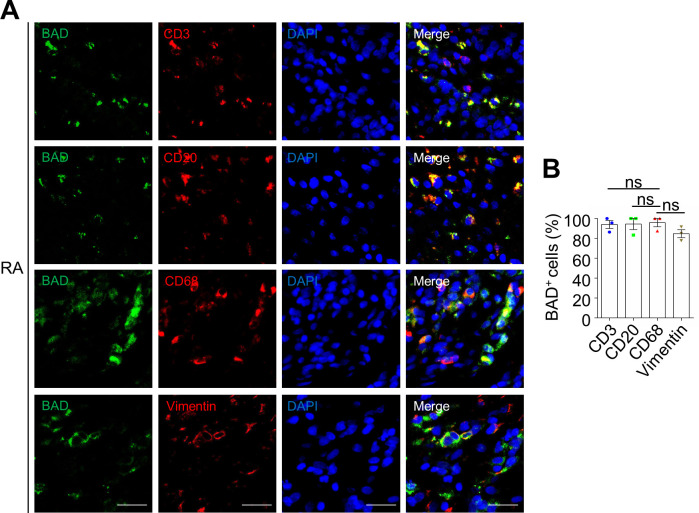
The expression of BAD is not cell-type specific in synovium of rheumatoid arthritis (RA) patients.(A) Double staining of BAD with T cell marker anti-CD3, B cell marker anti-CD20, macrophage marker anti-CD68, or synovial fibroblast marker anti-Vimentin in serial synovial specimen sections of patients with RA. Scale bar, 100 μm. (B) Quantification of percentages of BAD positive cells in total cells per field of different cell types (n = 3). Data are presented as mean ± SEM; dots represent individual human samples. Significant difference was analyzed by one-way ANOVA test.
Figure 8—figure supplement 1—source data 1.Source data for graphs in Figure 8—figure supplement 1.